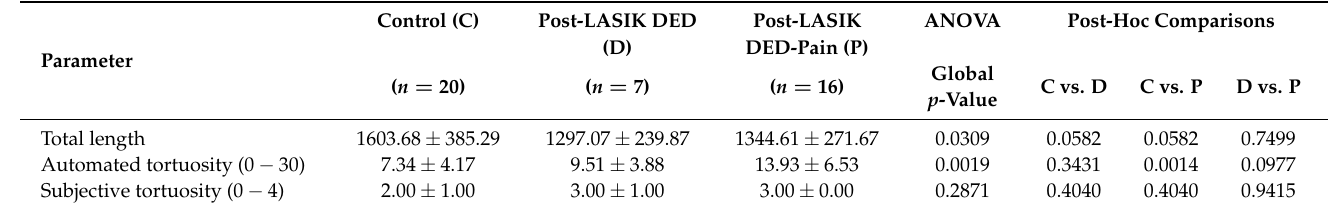
Table 2. Tortuosity indexes obtained from IVCM images for control and post-LASIK DED patients.